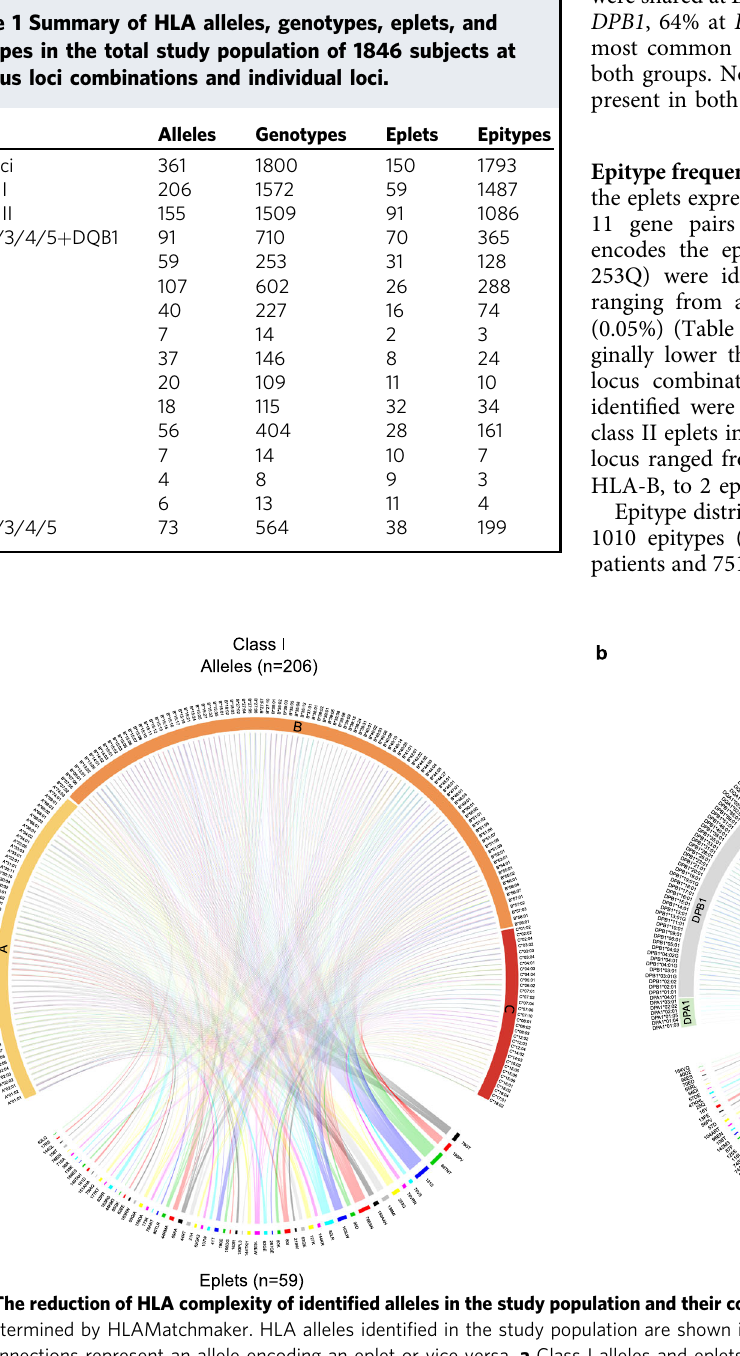
Table 1. The 206 class I alleles identi fi ed were combined in 1572